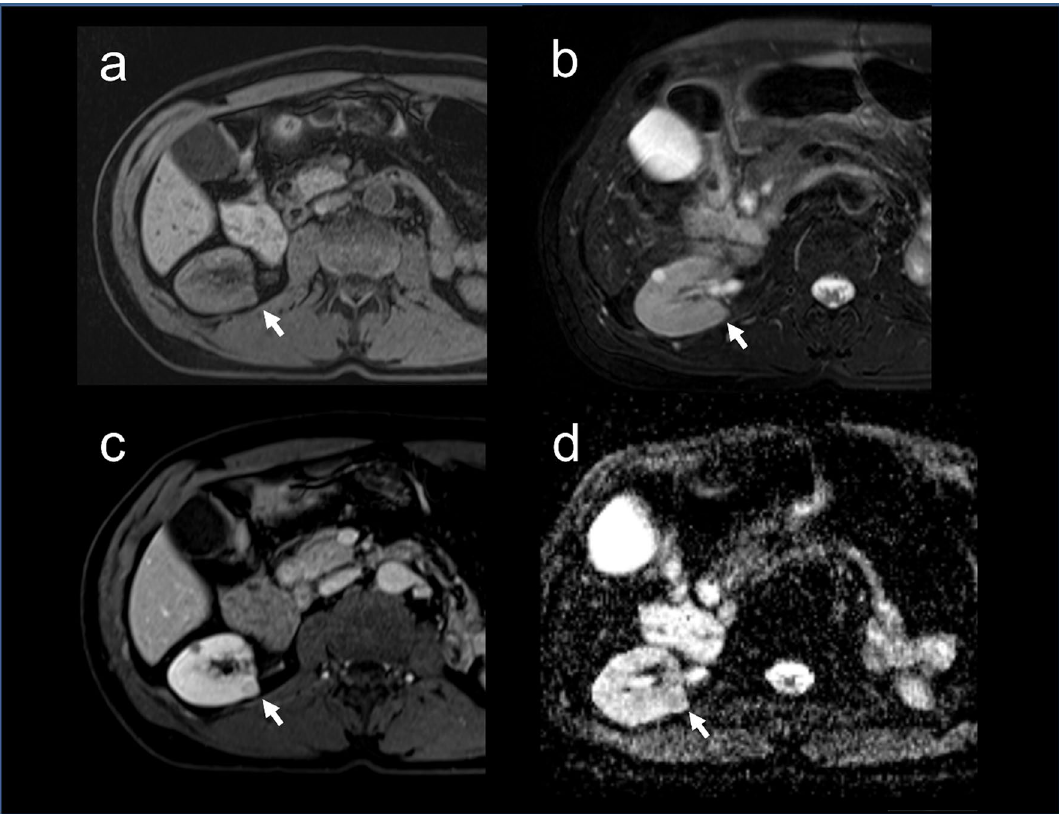
Figure 1. Radiological diagnosis of RCC in a GIST patient. MRI showing a coronal section of the abdomen with renal lesion (arrows). ( a ) T1 FS image showing a mild low signal intensity of a right posterior 8 mm renal mass. ( b ) T2 FS image showing increased intensity of the renal lesion. ( c ) T1 FS image showing hyperenhancement of the lesion after contrast injection. d. ADC MAP showing diffuse restriction of the